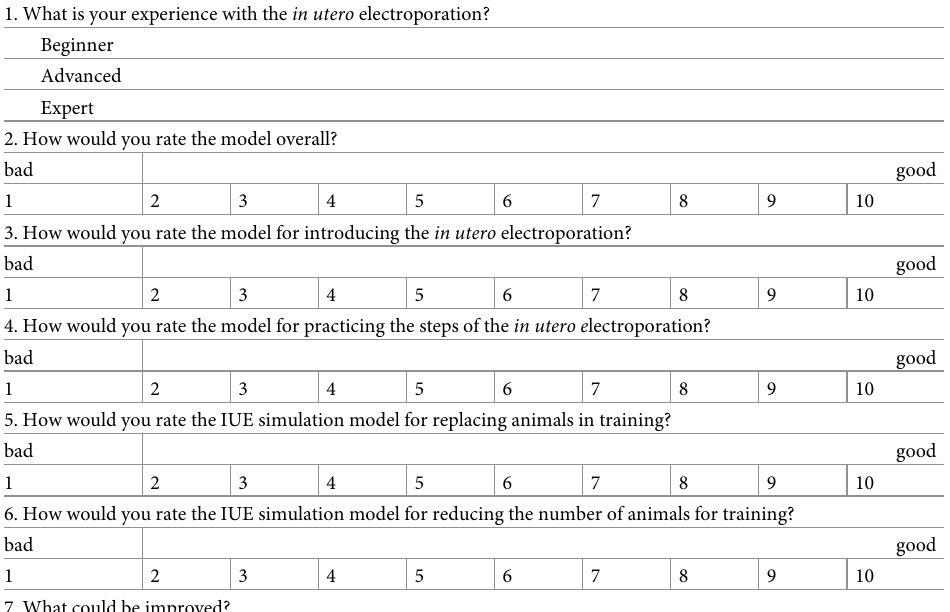
Table 1. Questionnaire for the in utero electroporation simulation model. 1. What is your experience with the in utero electroporation?